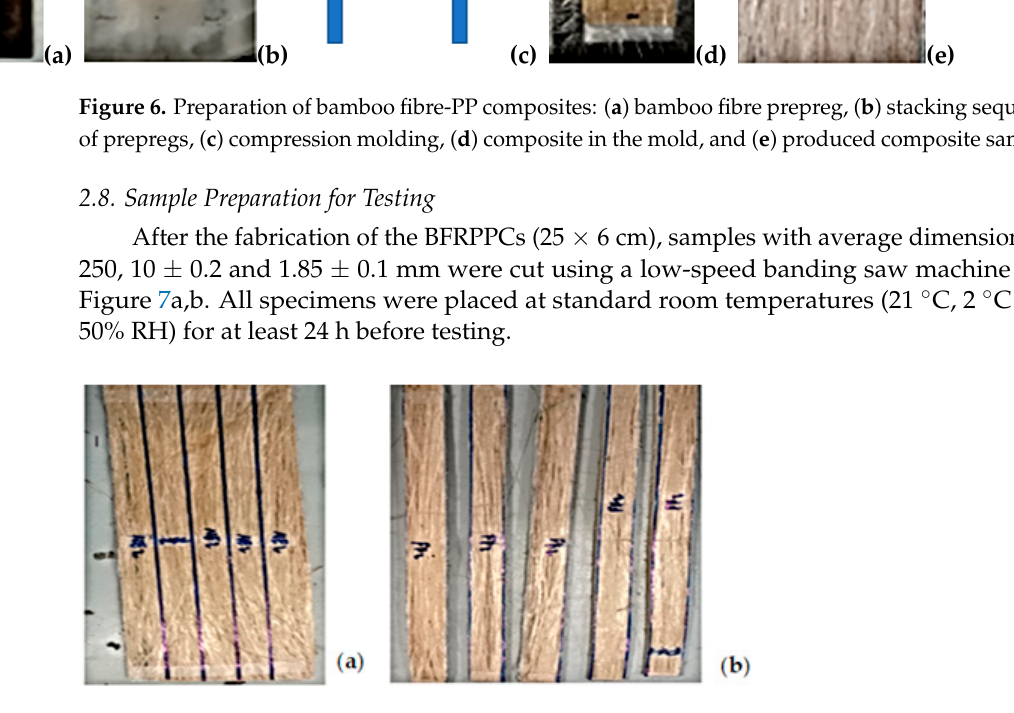
Figure 7. Samples view ( a ) samples layout for tensile testing, ( b ) after cutting using band saw.